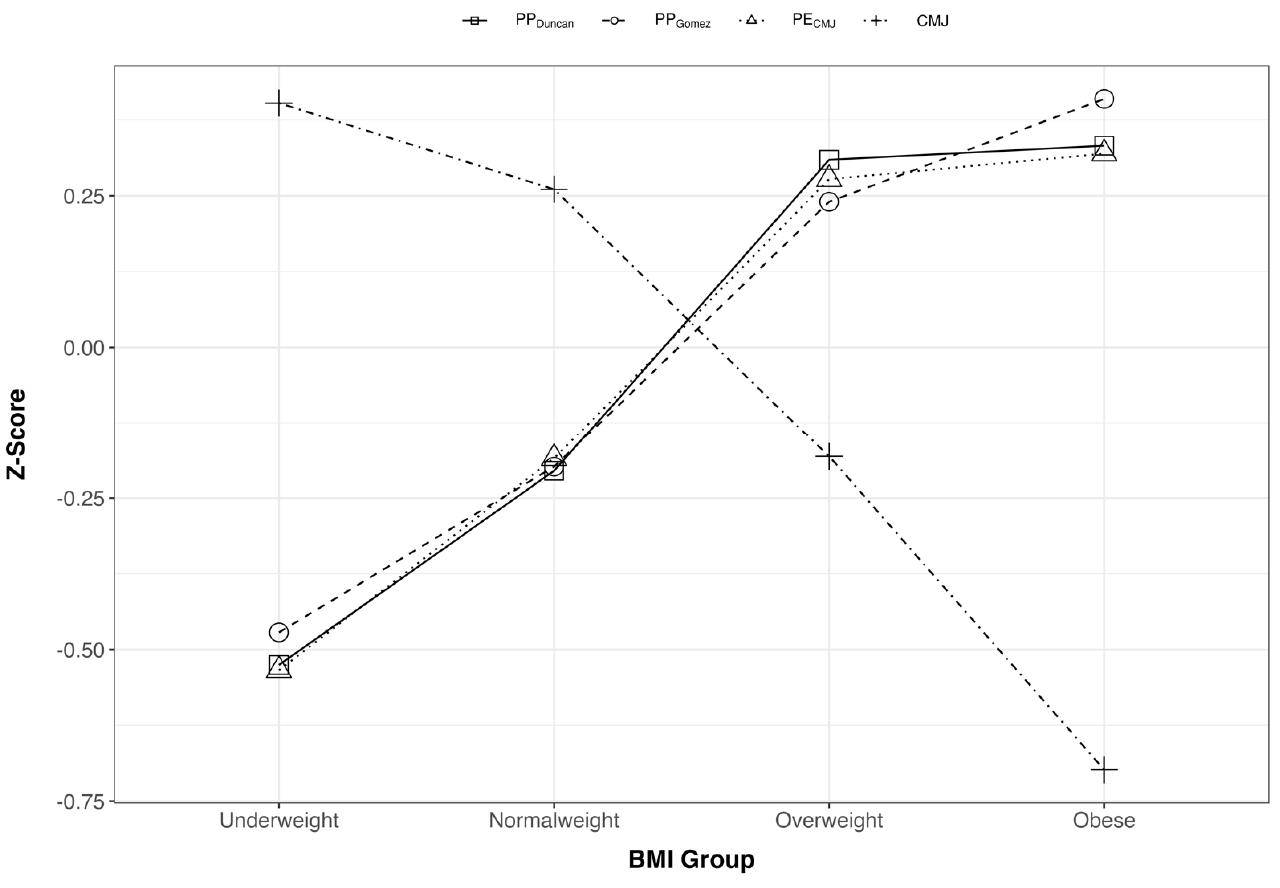
Figure 3. Trend of z-scores values for PP Duncan , PP Gomez , CMJ, PE CMJ by BMI group.